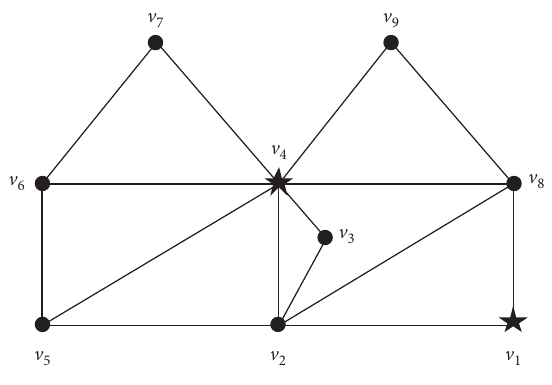
Figure 1: Graph model of a WSN covering Table 1: All the minimum externally independent sets (MEISs) of G .